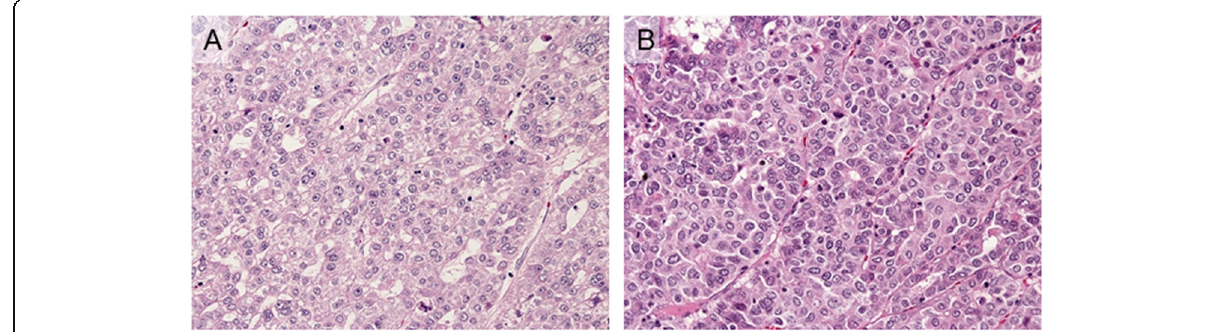
Fig. 3 Histological features of HCC and adrenal tumor. a HCC consists of tumor cells having round nuclei and eosinophilic cuboidal cytoplasm and shows trabecular or pseudoglandular pattern (× 200). b On adrenal tumor, tumor cells form trabecular or pseudoglandular architectures resembling those in the HCC (×